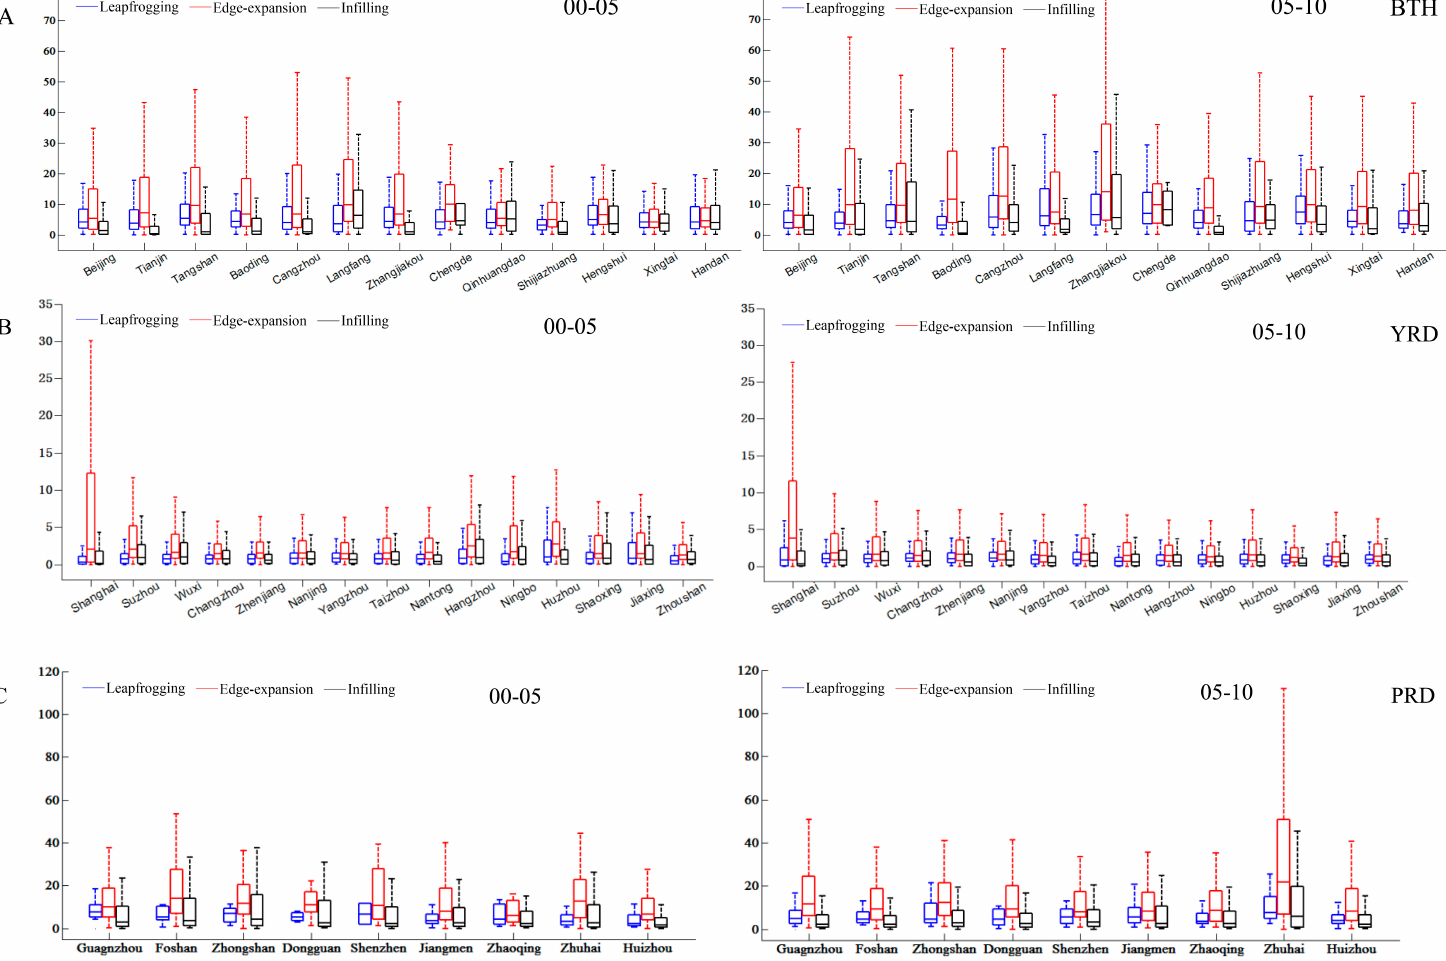
Figure 6. Size distribution for patches of the three expansion models for different cities of the three urban megaregions in two time periods, 2000–2005 and 2005–2010.